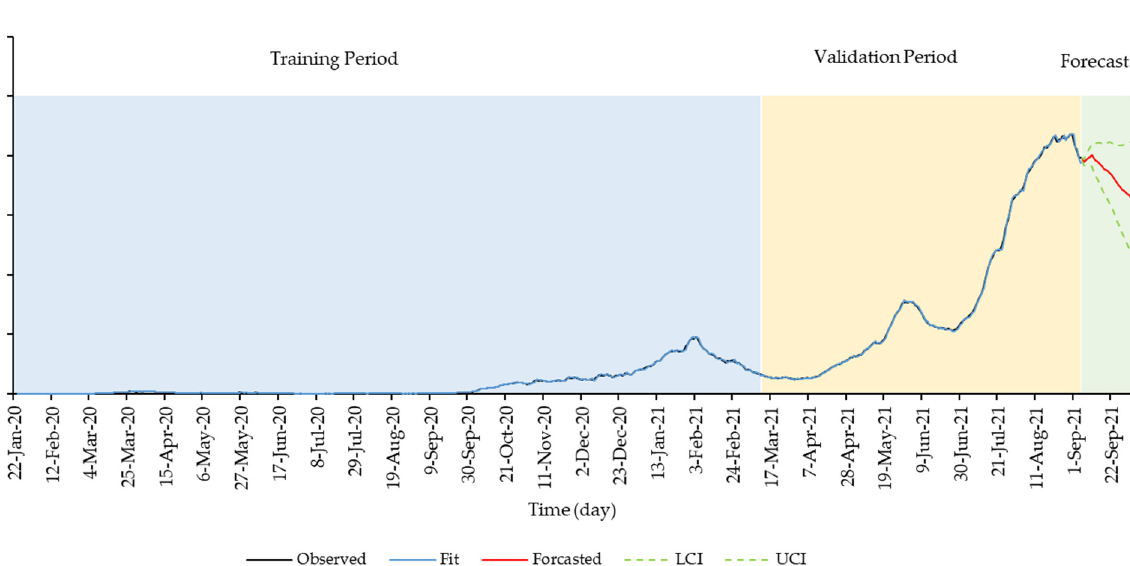
Figure 5. Deviation index of the SARIMA (1,2,1) (2,0,0) forecast from 6 September 2021 to 3 October 2021, Malaysia. 4. Discussion Being a novel disease, a detailed understanding of COVID-19 disease dynamics is limited resulting in difficulties to predict disease outbreaks. However, to ensure a balance between lives and livelihood, forecasting of disease outbreaks has become an important approach in assisting the management and control of the COVID-19 pandemic. It is evi- dence in the literature that forecasting using ARIMA models was able to provide reliable forecast results during the second wave of COVID-19 pandemic in Malaysia [28]. Despite having limited and stochastic data, a 7-day cyclical trend was observed in the time-series data, whereby a reduction of cases was usually observed during the week- ends, which could be due to variation in data collection and surveillance during week- ends. Hence, analysis using a seasonal component was carried out to determine the most appropriate time-series model. This is the first study to develop SARIMA models to fore- cast COVID-19 cases in Malaysia during the third wave (6 September 2021 to 3 October 2021), wherein this study found that SARIMA model (1,2,1) (2,0,0) was able to provide an